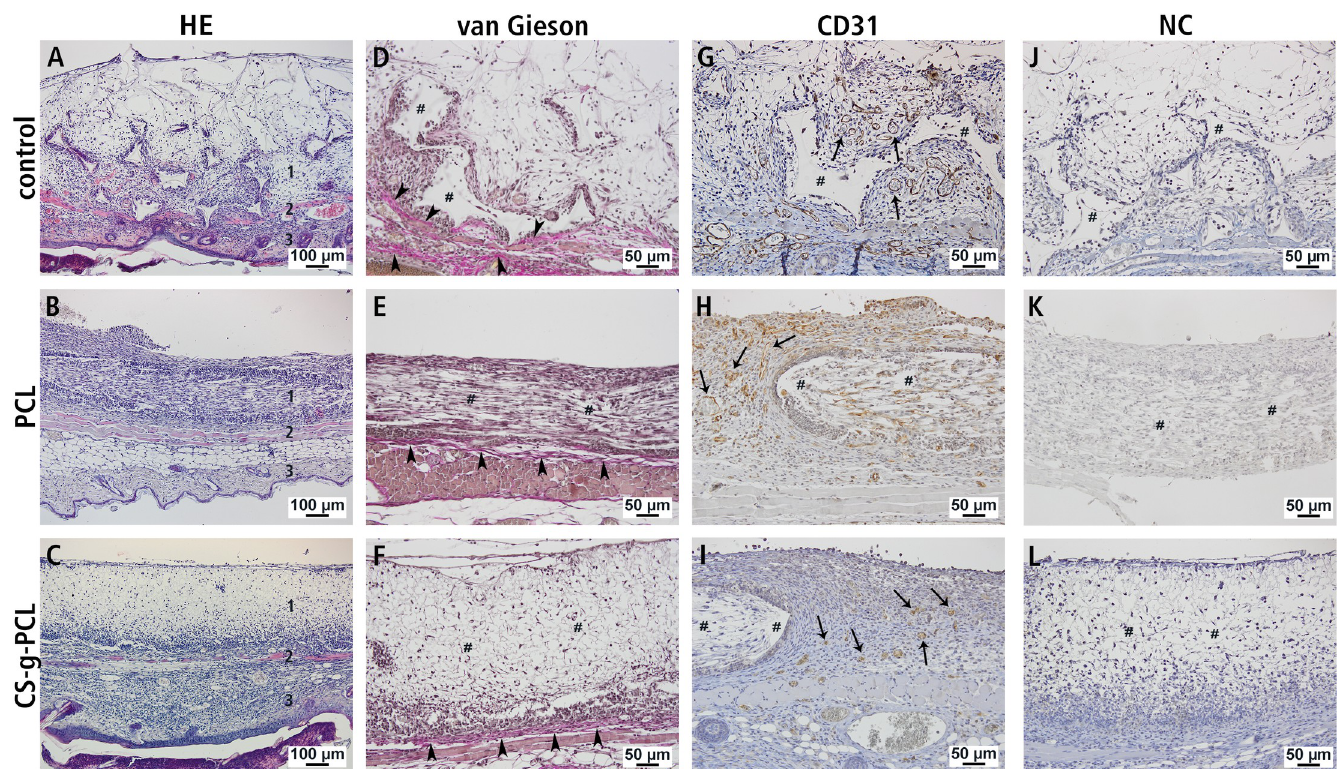
Fig 5. HE staining, van Gieson staining and immunohistochemical detection of CD31. Representative histological stainings (A-I) 14 days after implantation into the dorsal skinfold chamber of BALB/c mice. (A-C) HE staining (1) implant, (2) skin muscle, (3) subcutaneous tissue. (D-F) Collagen fibers were detected by van Gieson staining (arrowheads). (G-I) The presence of endothelial cells and accordingly enhanced functional capillary density was confirmed by immunohistochemical detection of CD31. (J-L) Negative controls. Areas of the implant are marked (#), arrows denote vascular structures. Scale bars: 100 μ m (A—C), 50 μ m